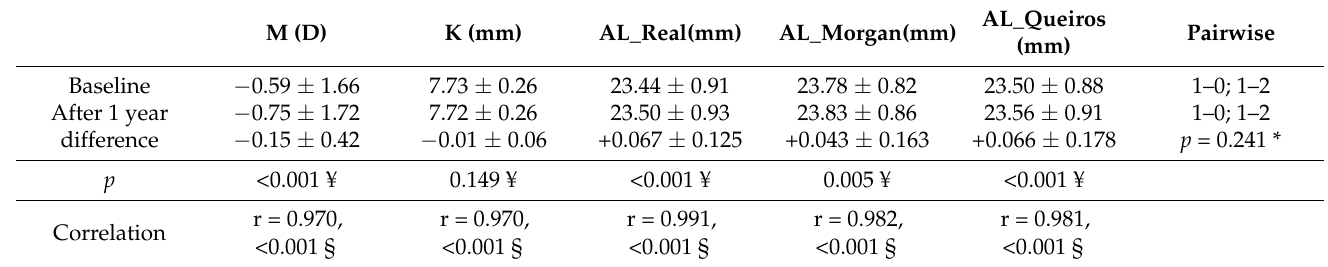
Table 2. Changes of the AL_Queiros equation compared to the AL_Morgan equation and the real value of AL, when compared longitudinally for a sample of 9 to 24 years old. Values are presented as mean ± SD.